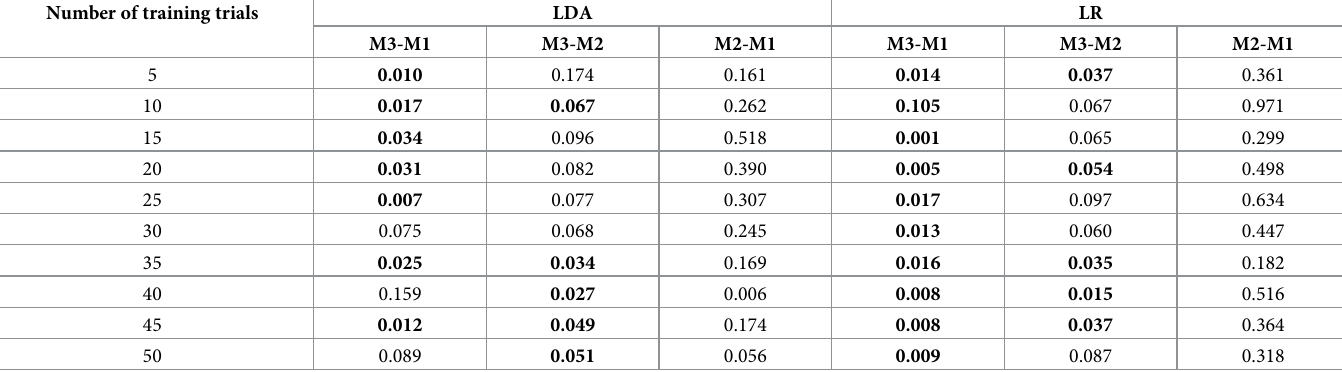
Table 2. p values of paired t-tests at 95% confidence level among the three algorithms Baseline (M1), EMD (M2) and EA-EMD (M3) based on two classifiers LDA and LR for data set 2. Number of training trials